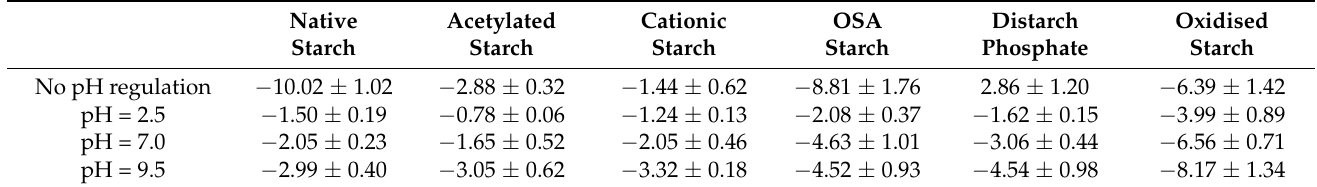
Table 5. ζ potential of analyzed starch samples [mV] for the analysed starch